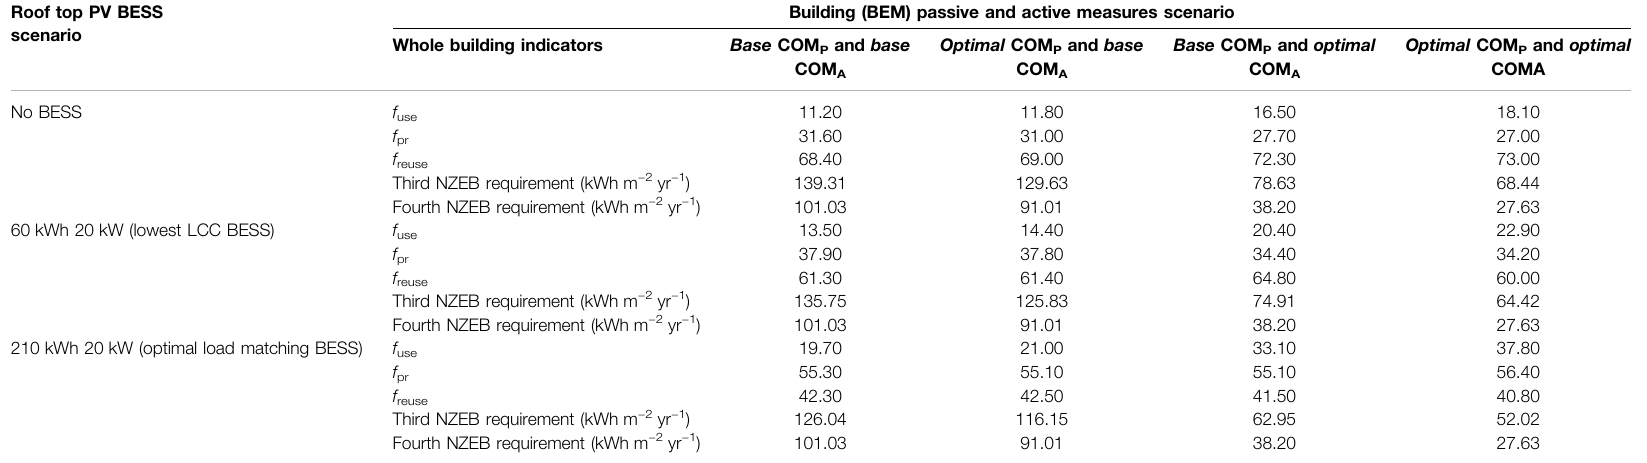
TABLE 6 | Whole building load matching, grid interaction and nearly zero energy buildings (NZEB) indicators under different passive, active and BESS